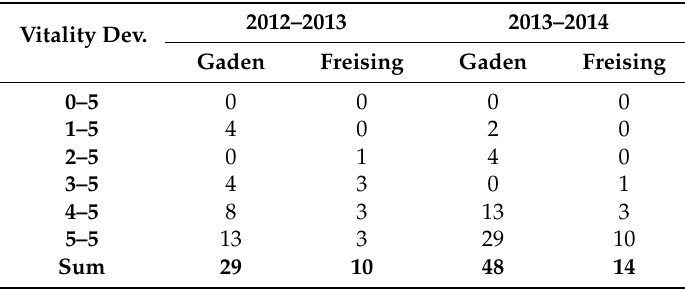
Table 5. Sum of dead ash trees in Gaden and Freising with rapid vitality changes in the years 2013 and 2014. Vitality Dev.